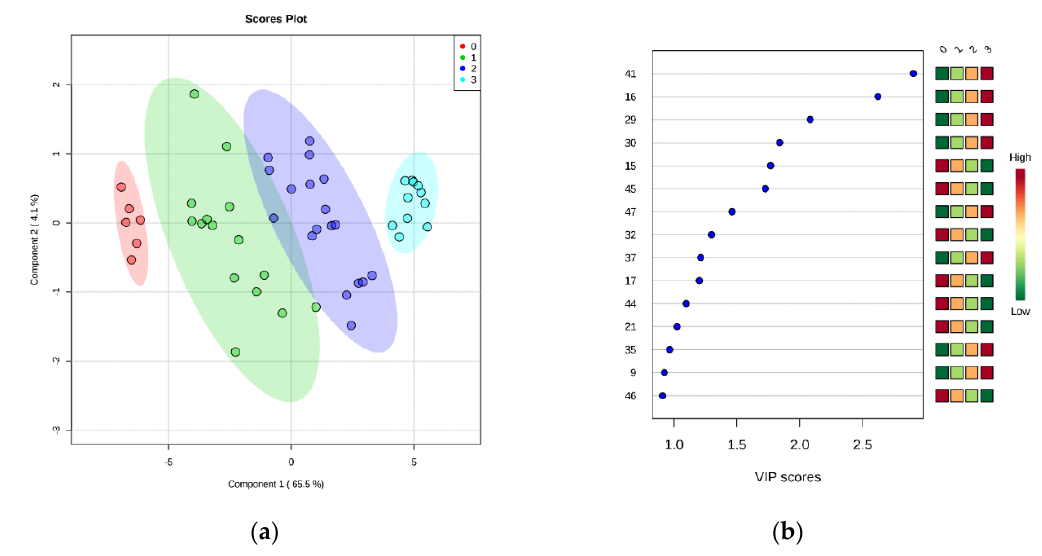
Figure 4. ( a ) Partial least squares discriminant analysis (PLS-DA) scores plotted for freshness grades of sea bream stored on ice. The legend indicates the four EU grades: Extra (0), A (1), B (2), unacceptable (3). ( b ) Top 15 metabolite features based on variable importance in projection (VIP) scores from PLS-DA. The x -axis shows the scores whereas the y -axis corresponds to GC–MS peak number from peak index (see Table 1). Color bars show median intensity of metabolite feature in the respective group.